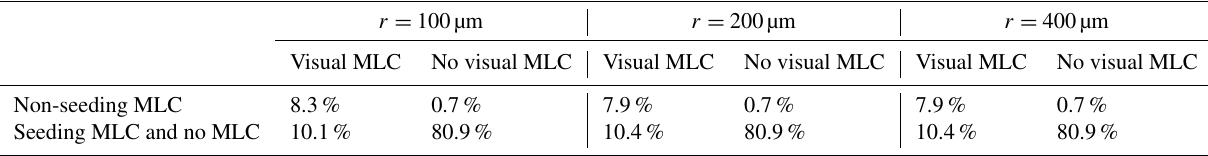
Table 5. Evaluation of the MLC results including only the non-seeding MLC of the classification step 2 in comparison to manual visual detection. “Non-seeding MLC” includes “only non-seeding” and “both seeding and non-seeding” MLC. “Seeding MLC and no MLC” includes seeding MLCs, single-layer clouds and no cloud layers. The evaluation is done for the ice crystal sizes r = 100, 200 and 400µm. The values are rounded to one decimal place.